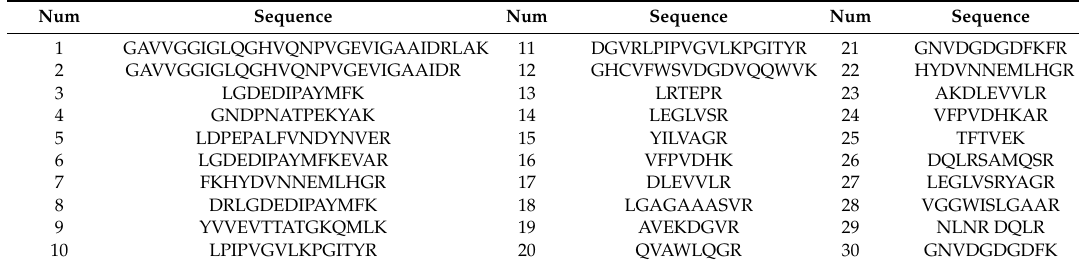
Table 4. The matched amino acid sequences between purified endo-1,4- β -xylanase and A0A3B6MY89.